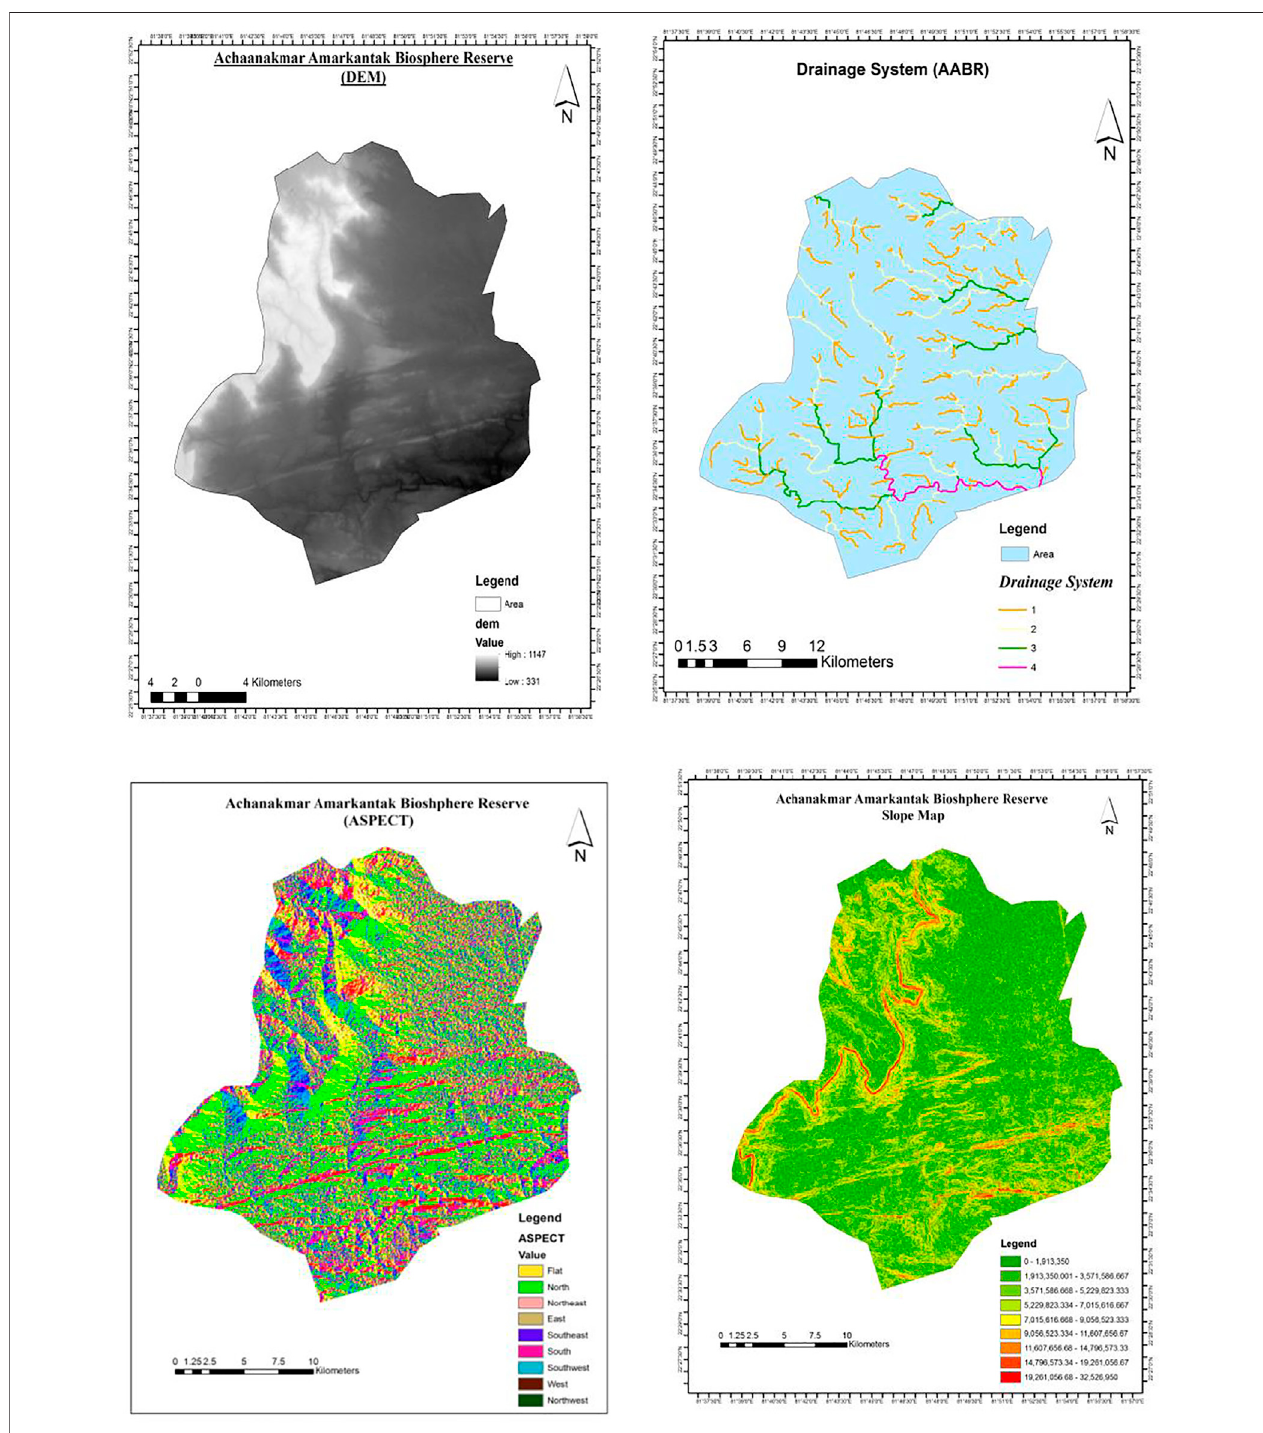
FIGURE 2 | Satellite map (A) Digital elevation model (DEM); (B) Drainage pattern; (C) Aspect map of the study area; (D) Slope map of AABR.